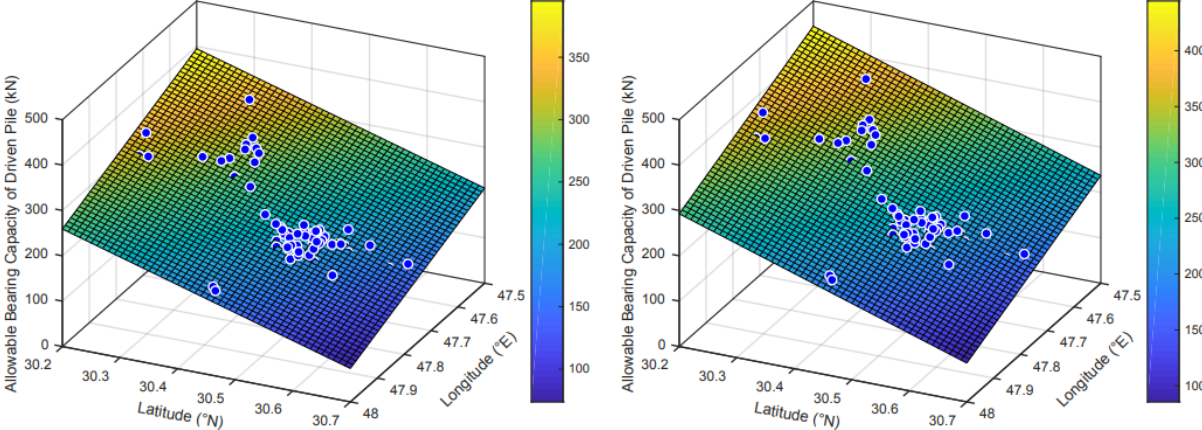
Figure 8: Surface defining the variation of the allowable bearing capacity of the driven pile having 8 m length